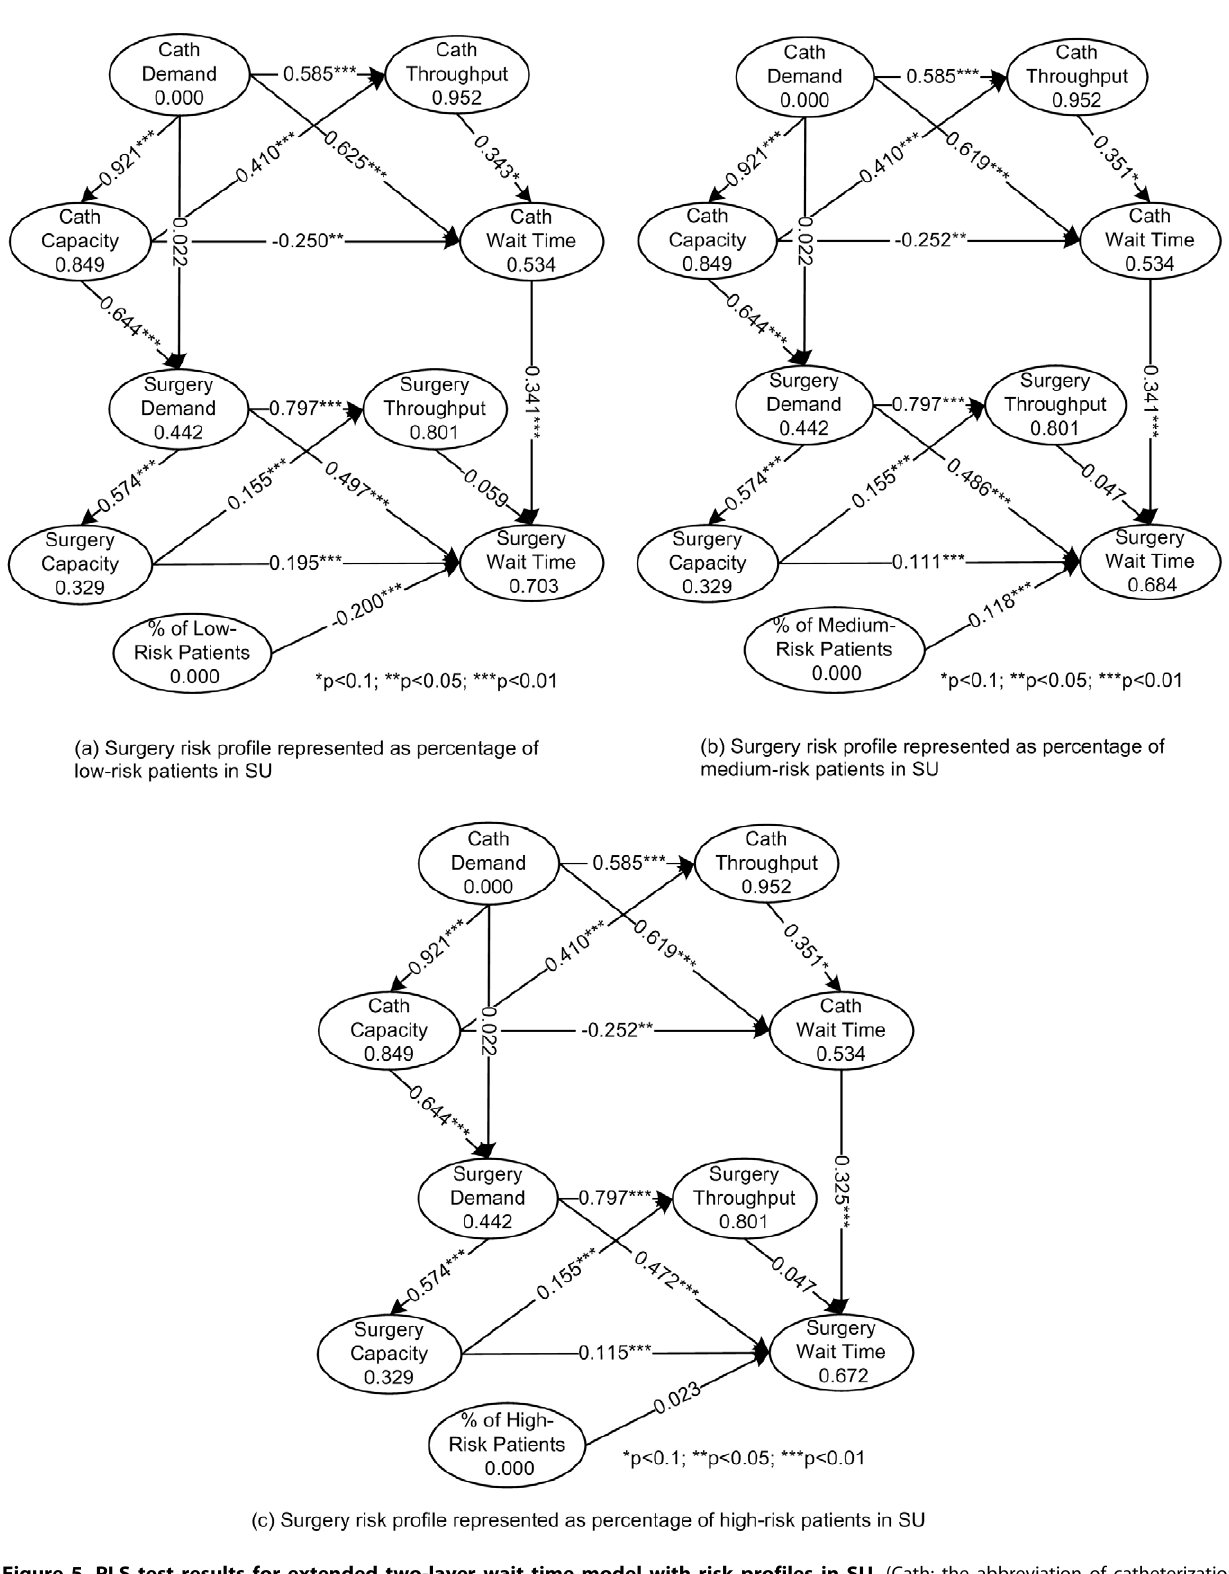
Figure 5. PLS test results for extended two-layer wait time model with risk profiles in SU. (Cath: the abbreviation of catheterization; Surgery: the shorter form of cardiac surgery.)